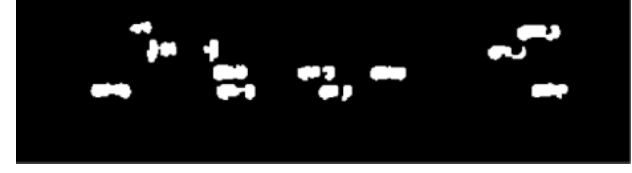
Figure 2. Preliminary recognition results of moving